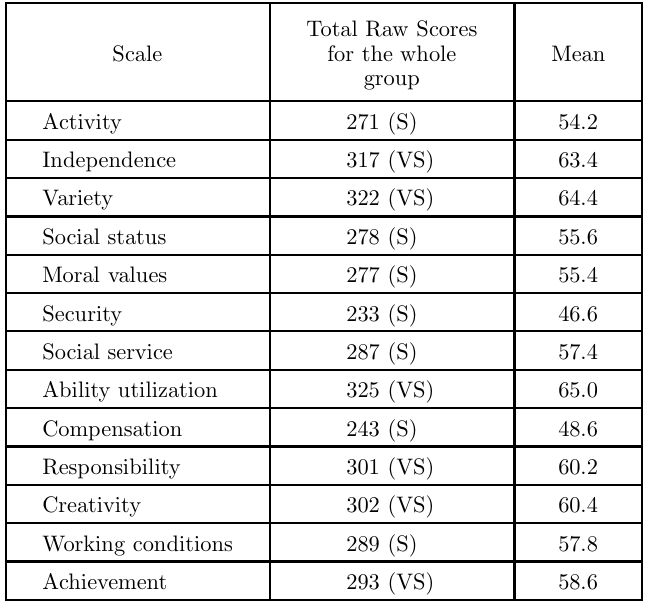
General Satisfaction Score Total Raw Scores Scale for the whole Mean group Activity 271 (S) 54.2